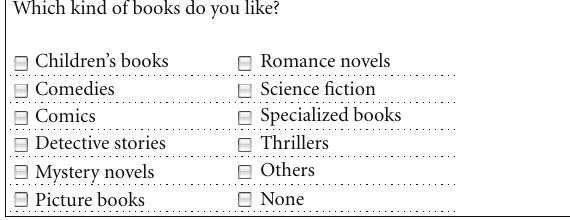
Figure 1: Example for checkbox condition (translated by the authors).